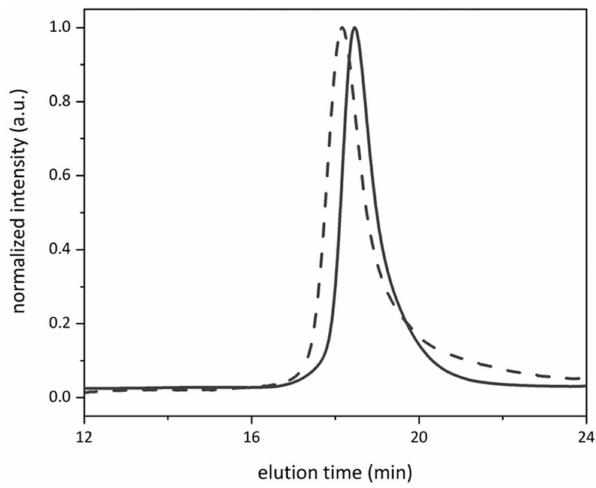
Figure 2. Gel permeation chromatography (GPC) chromatograms of 1 (line) and 3 (dash) in tetrahydrofuran (THF).